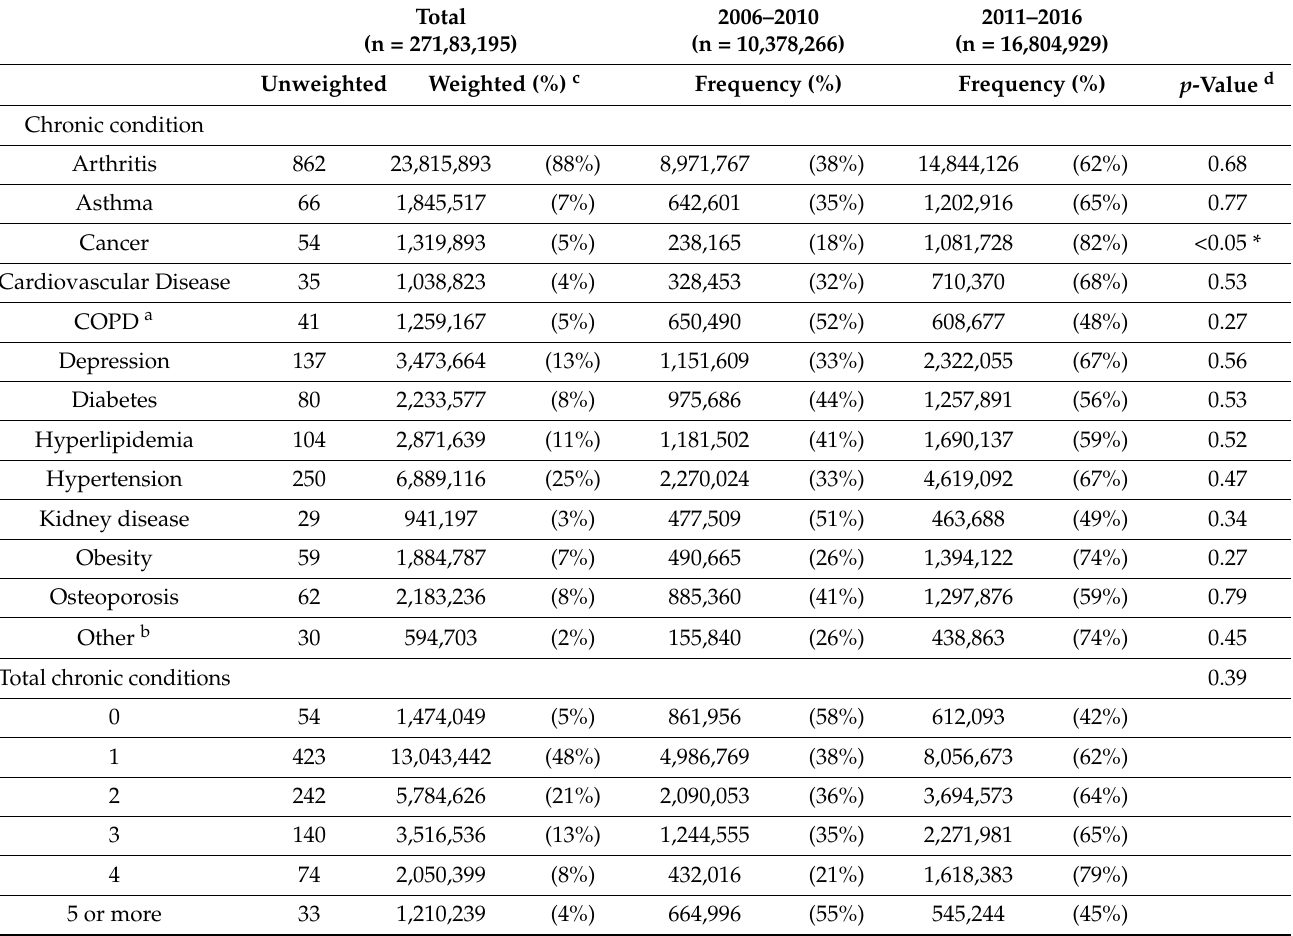
Table 2. Chronic conditions reported for lupus patient visits from 2006 to 2016.